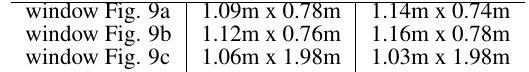
Table 3. Comparision of window size ∆ H x ∆ L measured (center) and extracted from SAR image (right) window Fig.